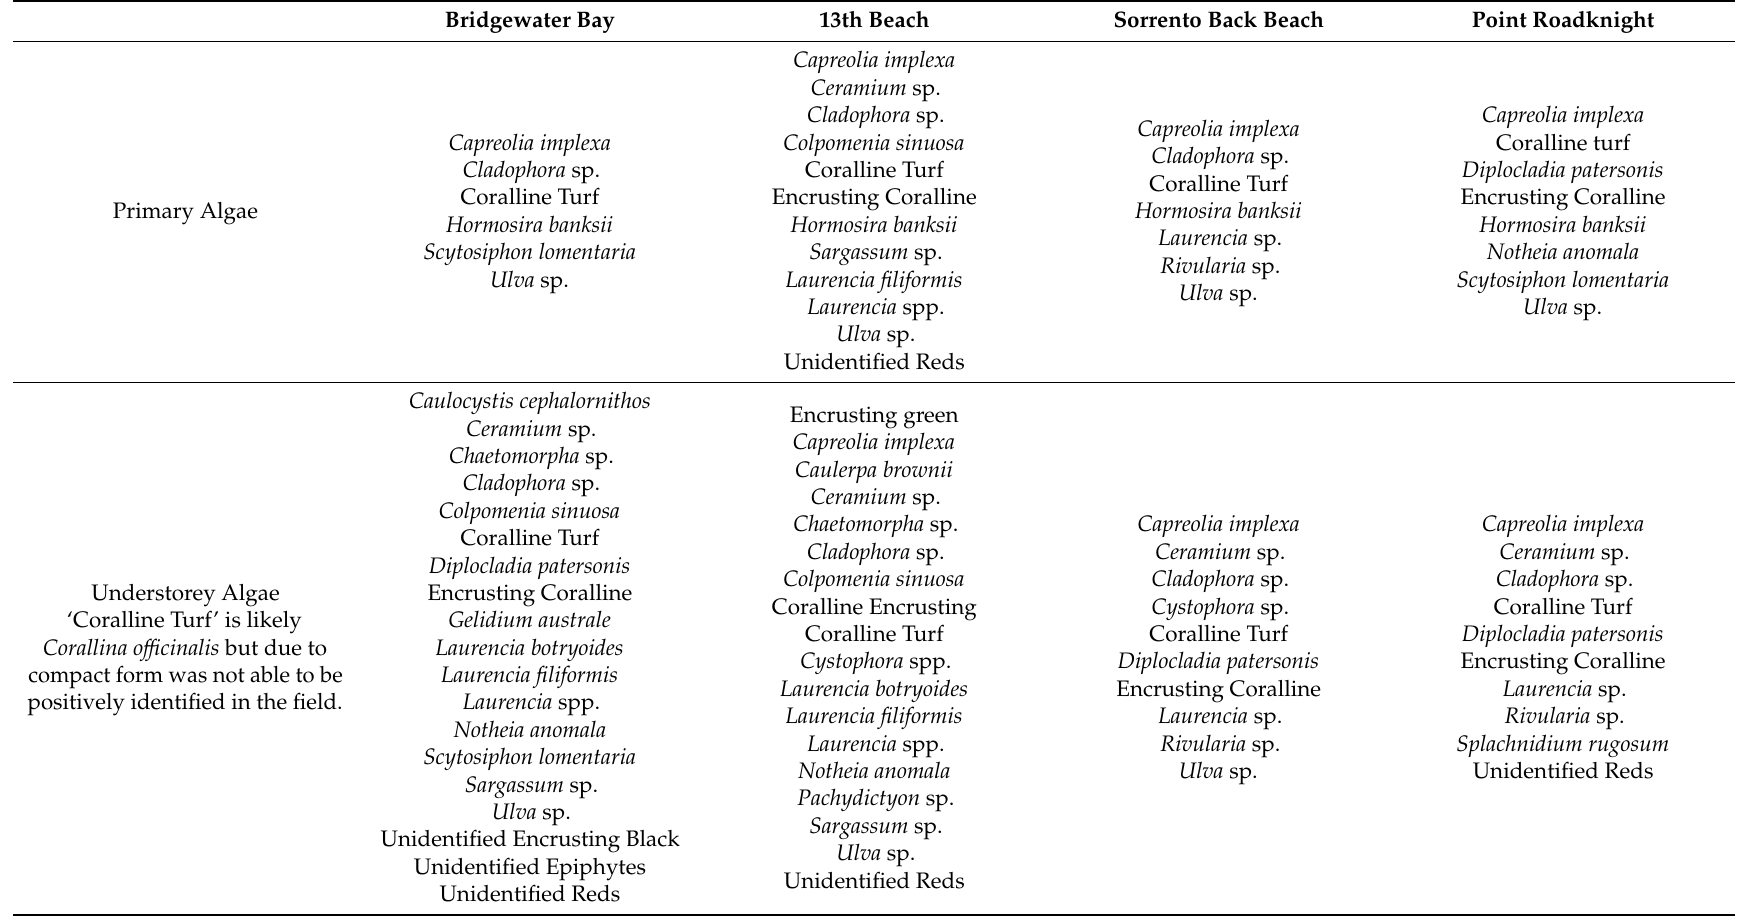
Table A1. Species and component list by site and type ( > 78